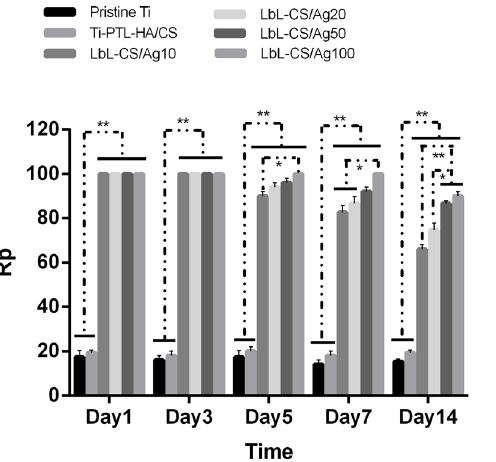
Fig 6. Antibacterial rates against planktonic bacteria in medium (Rp). The antibacterial assays data are expressed as means ± standard deviations (n = 3). One-way ANOVA followed by SNK post hoc test is utilized to determine the level of significance. * p < 0.05 and ** p < 0.01.